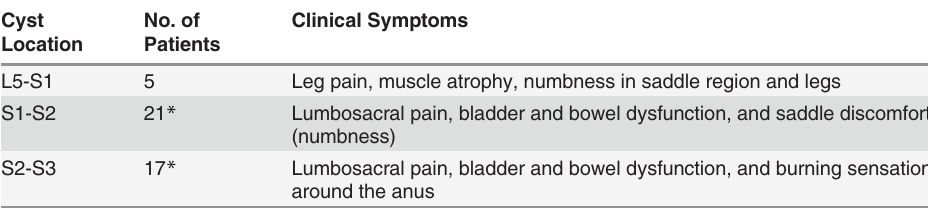
Table 1. Summary of cyst characteristics and clinical symptoms in 42